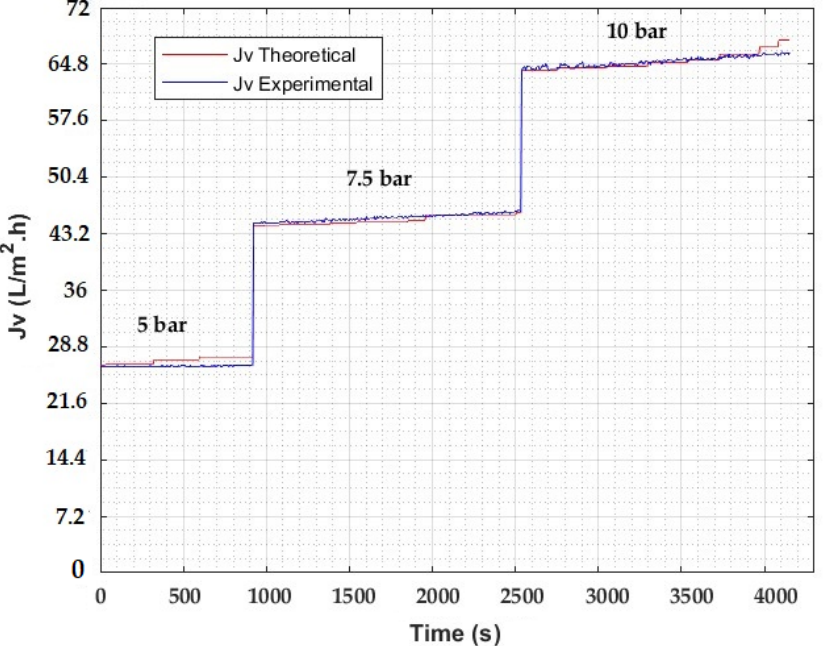
Figure 13. Theoretical vs. experimental flux of Pb: high concentration.